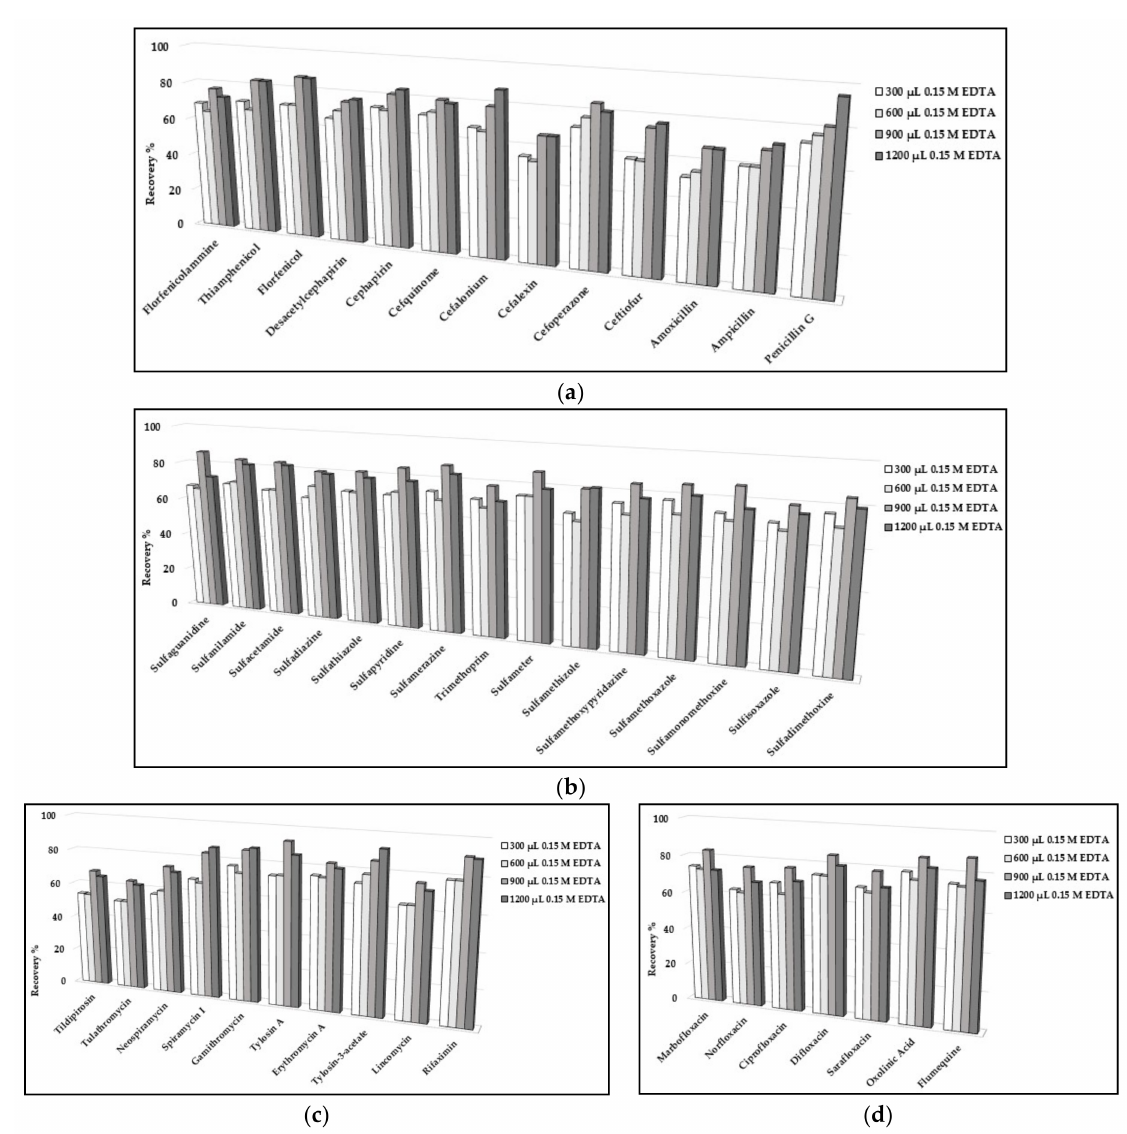
Figure 1. Extraction efficiency of different volumes of EDTA solution evaluated in egg samples (n = 4 per experiment) spiked at 10 µ g kg − 1 for ( a ) amphenicols and beta-lactams, ( b ) sulfonamides and trimethoprim, ( c ) lincomycin, rifaximin and macrolides, and ( d )